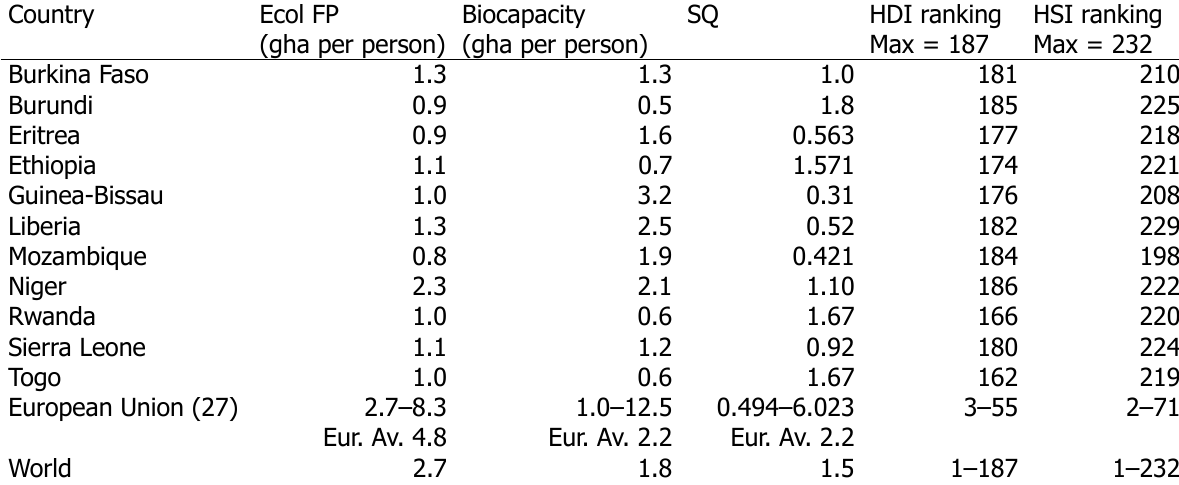
Table 1. Eleven of the world's poorest countries are compared to the European Union and the world average in their extent of sustainability. Example: Each citizen of Eritrea uses the equivalent of 0.9 global hectares to sustain their livelihood; the country of Eritrea has 1.6 global hectares of bioproductive land to offer to each citizen; this results in an SQ of 0.563, meaning that Eritreans live within the carrying capacity of their land. Sources: